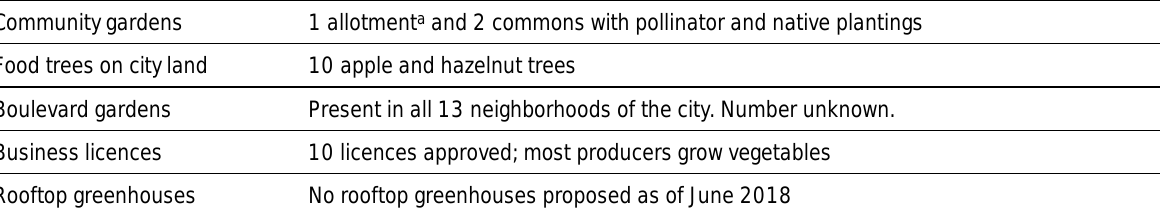
Table 2. Number of New Community Gardens, Food Trees, Boulevard Gardens, Business Licences,